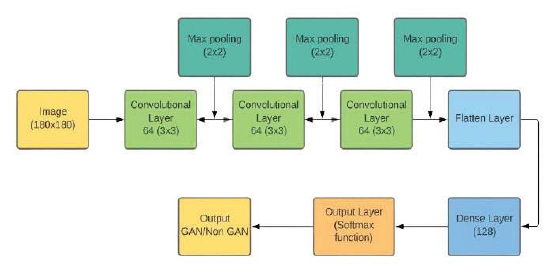
Fig. 5. CNN model used in the second part of the system i.e. plagiarism